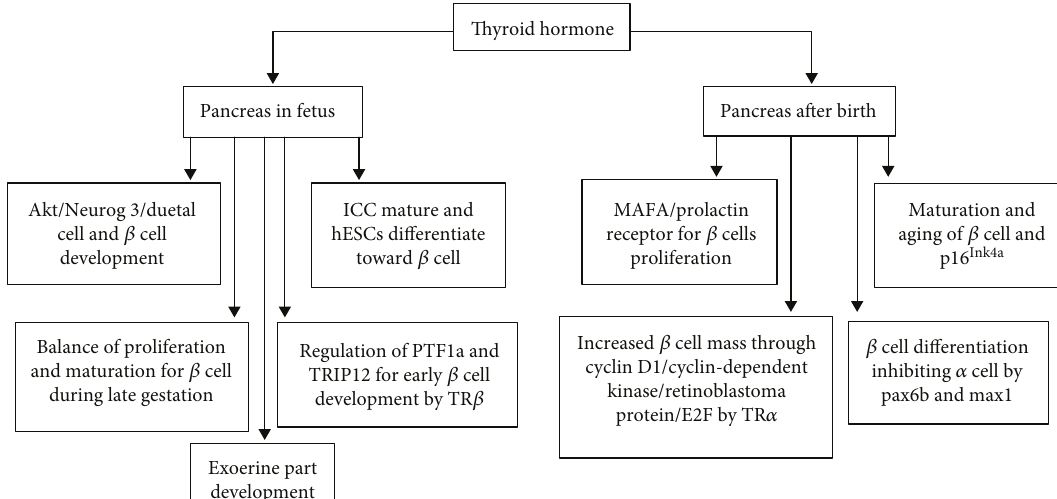
Figure 1: The physiological e ff ect of thyroid hormones on pancreatic development. Akt: RAC-alpha serine/threonine-protein kinase; E2F: E2F transcription factor; hESC: human embryonic stem cell; ICC: islet-like cluster; MAFA: musculoaponeurotic fi brosarcoma oncogene family A; MNX1: motor neuron and pancreas homeobox 1; pax6b: paired box protein 6b; p16 Ink4a : cyclin-dependent kinase inhibitor 2; PTF1a: pancreas transcription factor 1a; TR: thyroid hormone receptor; TRIP12: thyroid hormone receptor-interacting